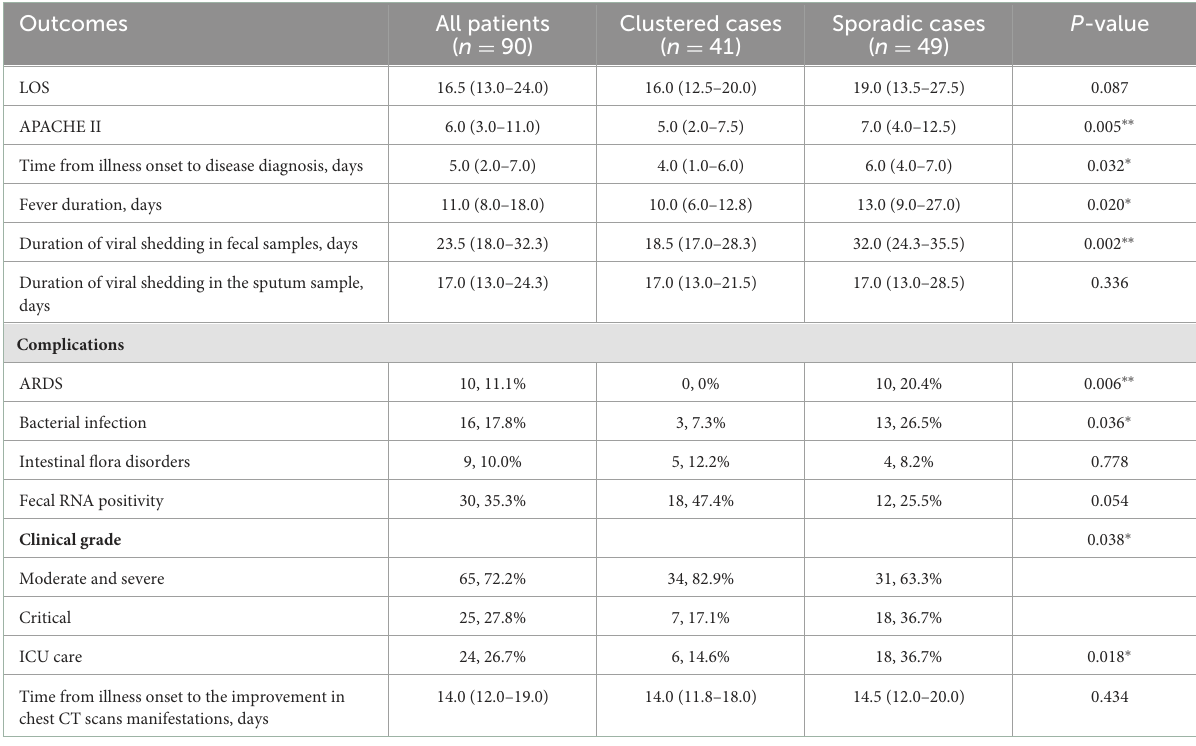
TABLE 3 Clinical outcomes of 90 patients with laboratory confirmed coronavirus disease 2019 infection.